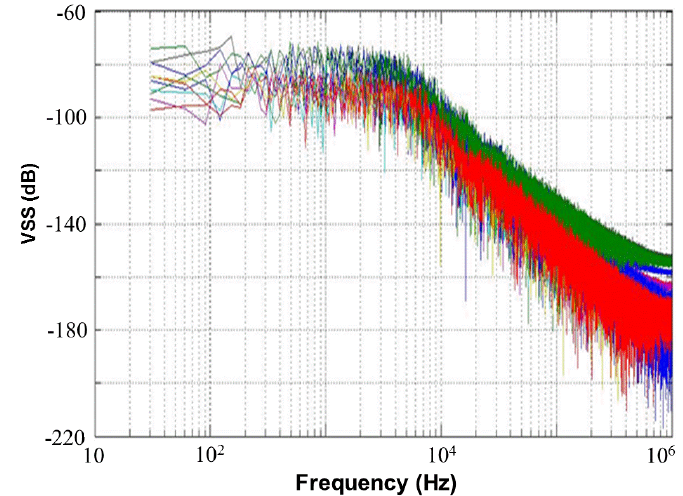
Figure 13. Frequency response of simulated 10 Monte Carlo samples with random noises at node V